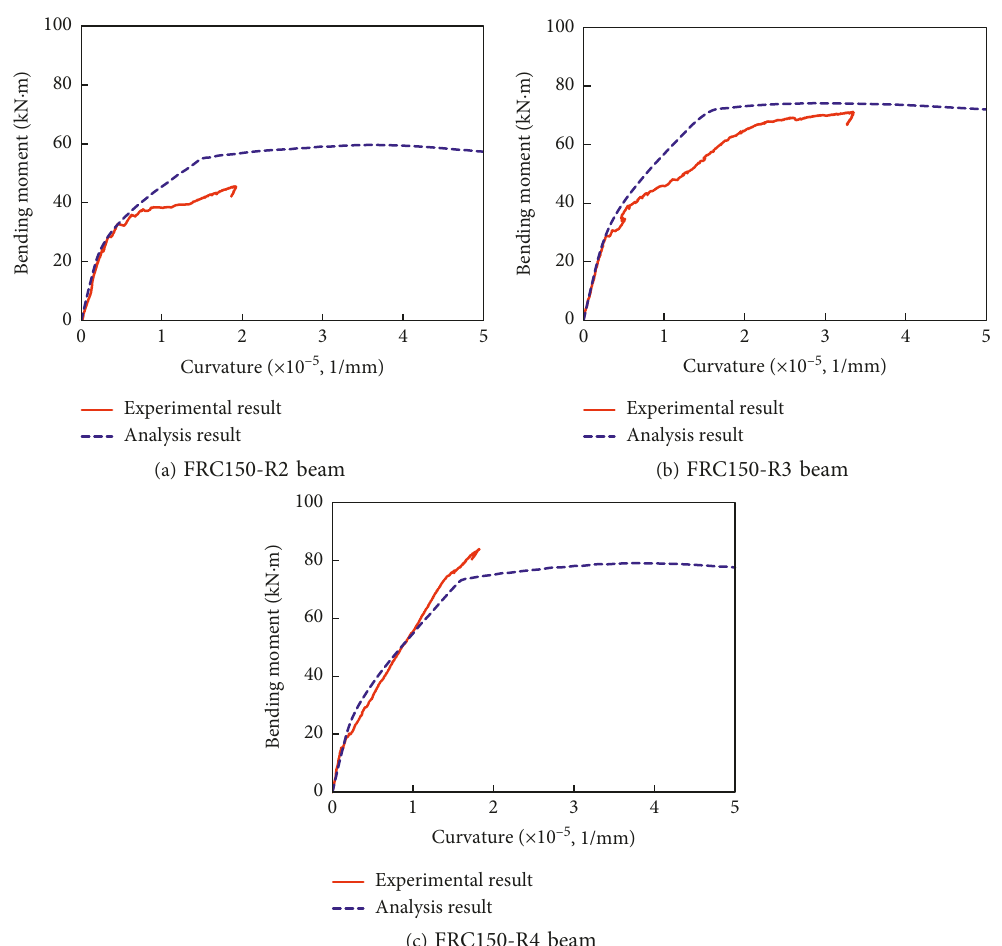
Figure 13: Prediction of moment-curvature curves (FRC150 series